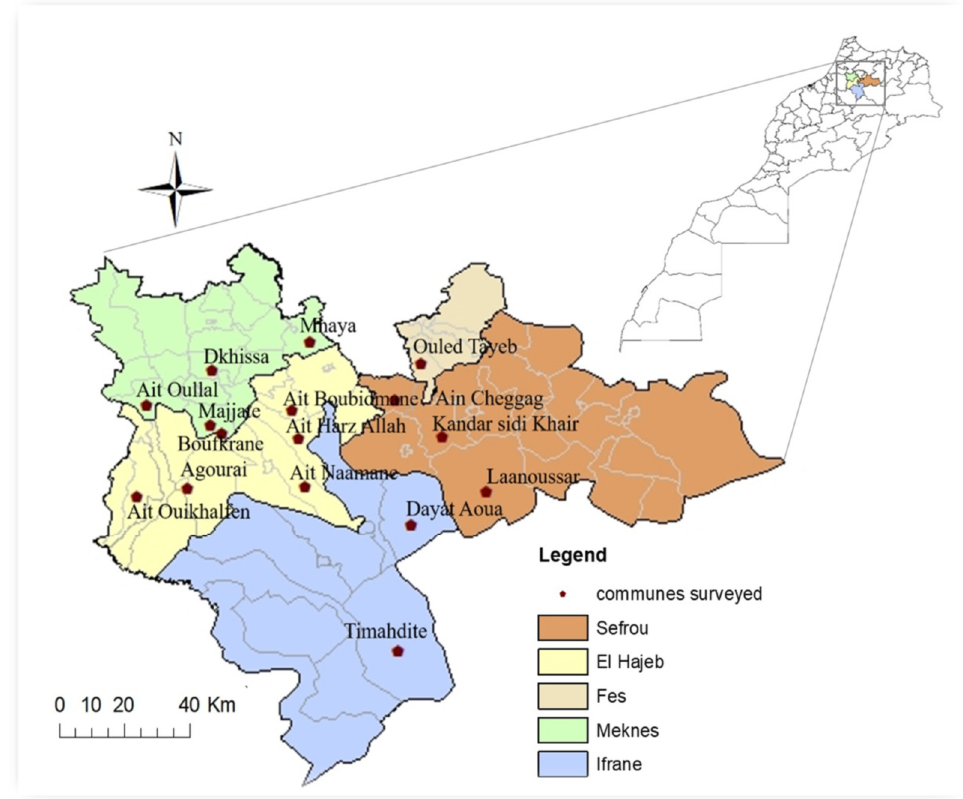
Figure 1. Location of the studied area.